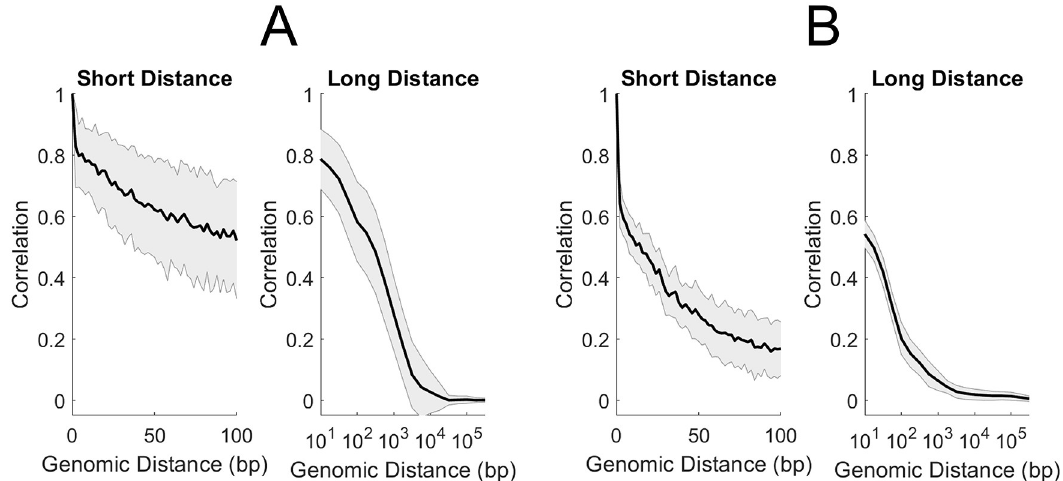
Fig 7. Correlation of fraction methylation f (A) and remethylation rates k (B) with Genomic Distance (GD). Correlation over short distances (left) and long distances (right) for Chr1.